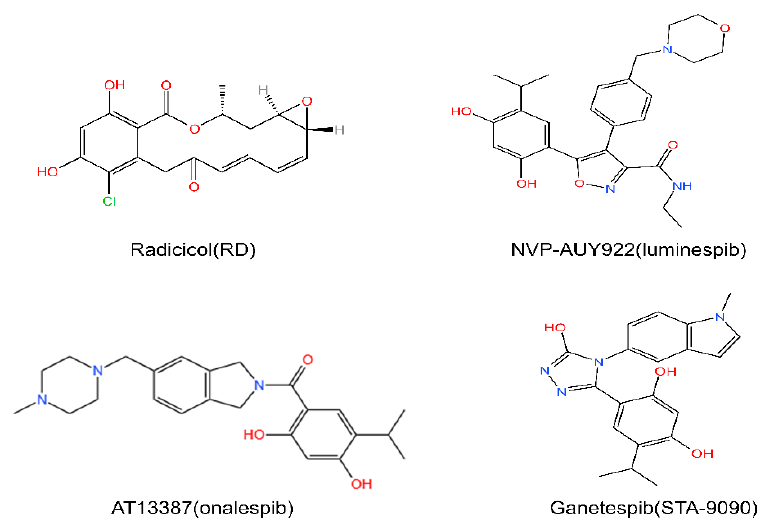
Figure 4. Chemical structures of RD-derived HSP90 inhibitors. RD and its derivatives NVP-AUY922, AT13387, Ganetespib. Chemical structures are from http://www.chemspider.com (Accessed on 16 August 2022).